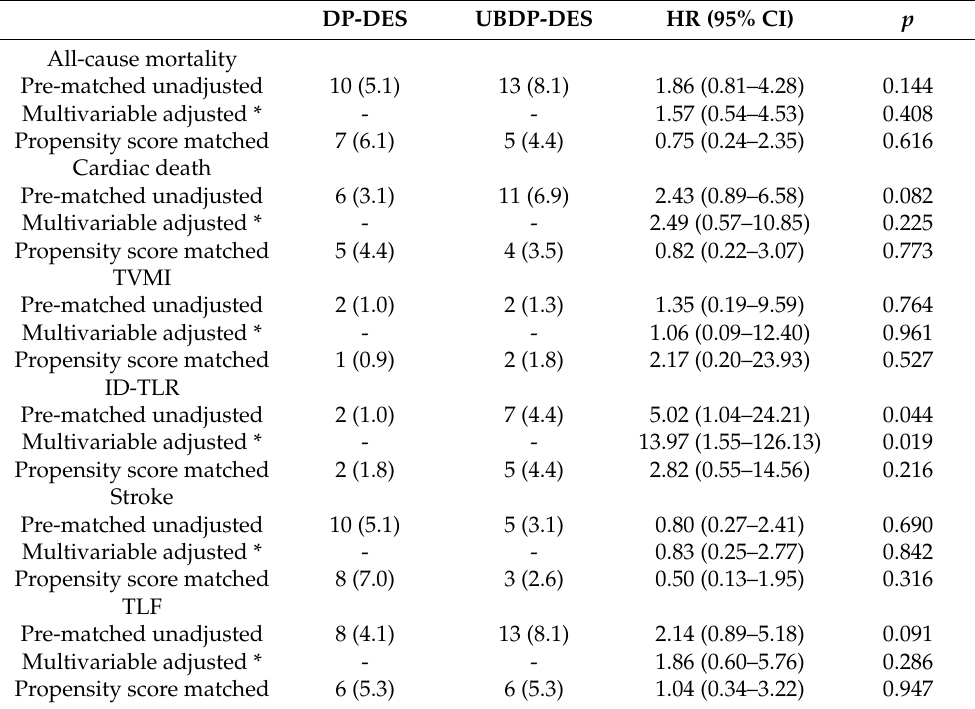
Table 5. Clinical events with multivariable adjustment and pre-/post-PSM using Cox